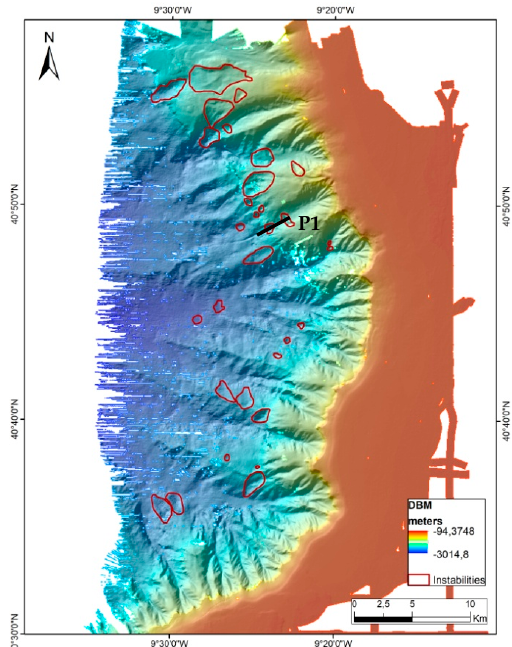
Figure 3. Delimitation of submarine mass movement (SMM) morphologic evidence, in the upper course of Aveiro Canyon. The black line indicates the location of profile P1 (see Figure 4).